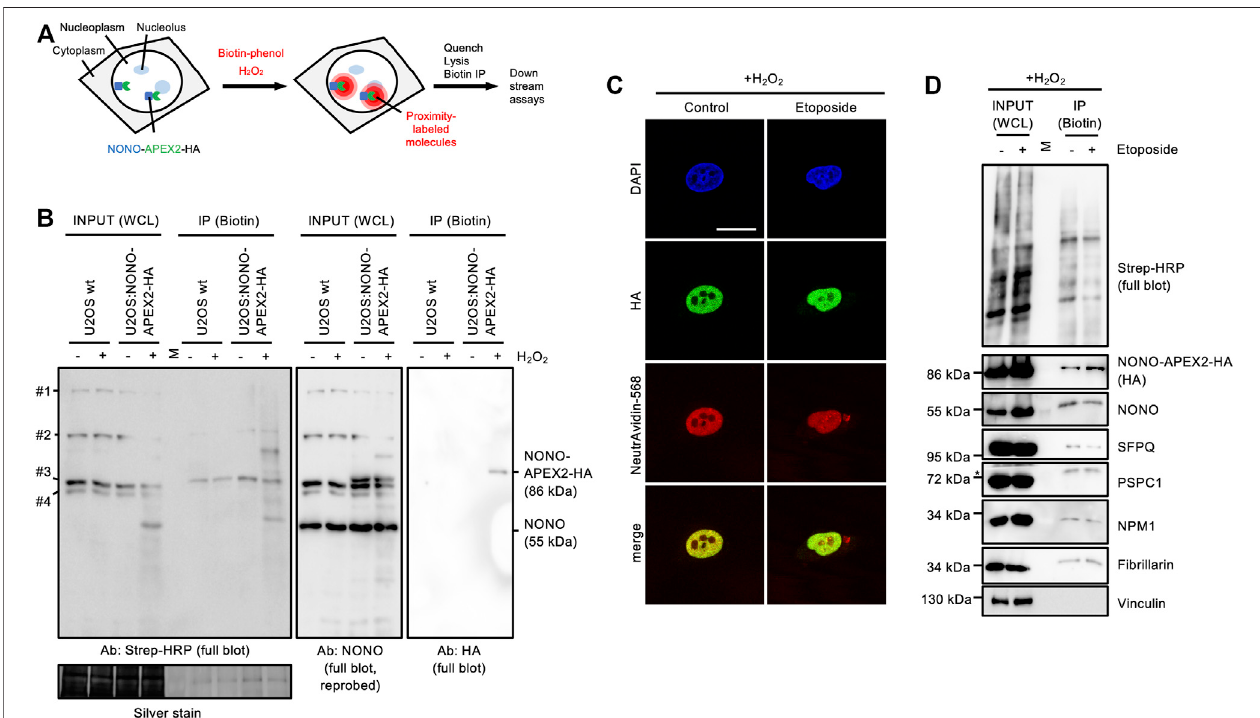
FIGURE 4 | In vivo proximity labeling in U2OS:NONO-APEX2-HA cells. (A) Work fl ow of in vivo proximity labeling including expression of the APEX2 fusion protein, addition of biotin-phenol and hydrogen peroxide (H 2 O 2 ), quenching of reaction, lysis and immunoprecipitation of biotinylated proteins (Biotin IP). (B) Immunoblots detecting biotinylated proteins (Strep-HRP), NONO and NONO-APEX2-HA from whole cell lysates (WCL) or upon IP from wt U2OS or U2OS:NONO-APEX2-HA cells treated with or without (+/-) H 2 O 2 . #1, CoA carboxylase (280 kDa); #2, Pyruvate carboxylase (128 kDa); #3, Propionyl-CoA carboxylase (74 kDa); #4, β - methylcrotonyl-CoA carboxylase (72 kDa); Ab, antibody; Strep-HRP, streptavidin-horse radish peroxidase; M, protein standard; silver stain, loading control. (C) ConfocalimagingofNONO-APEX2-HAandbiotin(NeutrAvidin-568)+/-Etoposide(20 μ M,2 h).Representativeimagesareshown.DAPI,4 ‘ ,6-diamidino-2-phenylindol; scale bar, 10 µm. (D) Immunoblots detecting biotin (Strep-HRP) or indicated proteins from WCL or after IP ± Etoposide (20 μ M, 2 h). M, protein standard; asterisk, cut